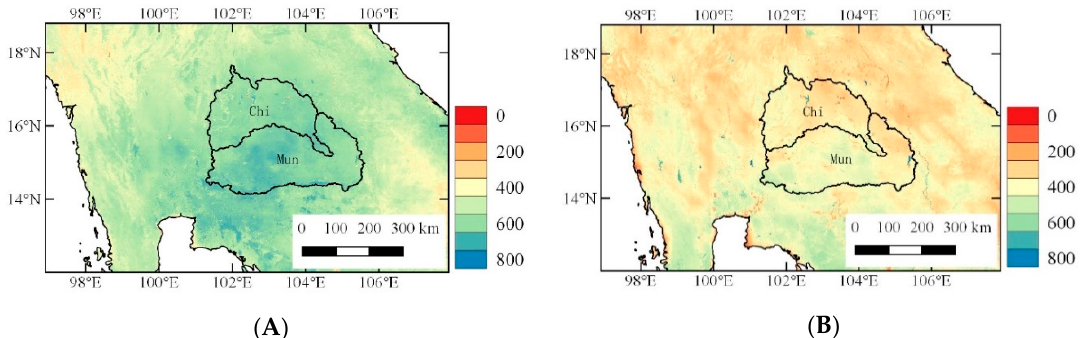
Figure 11. Spatial variation of ( A ) wet and ( B ) dry season ET (mm) in Northeastern Thailand from 2001 to 2015.